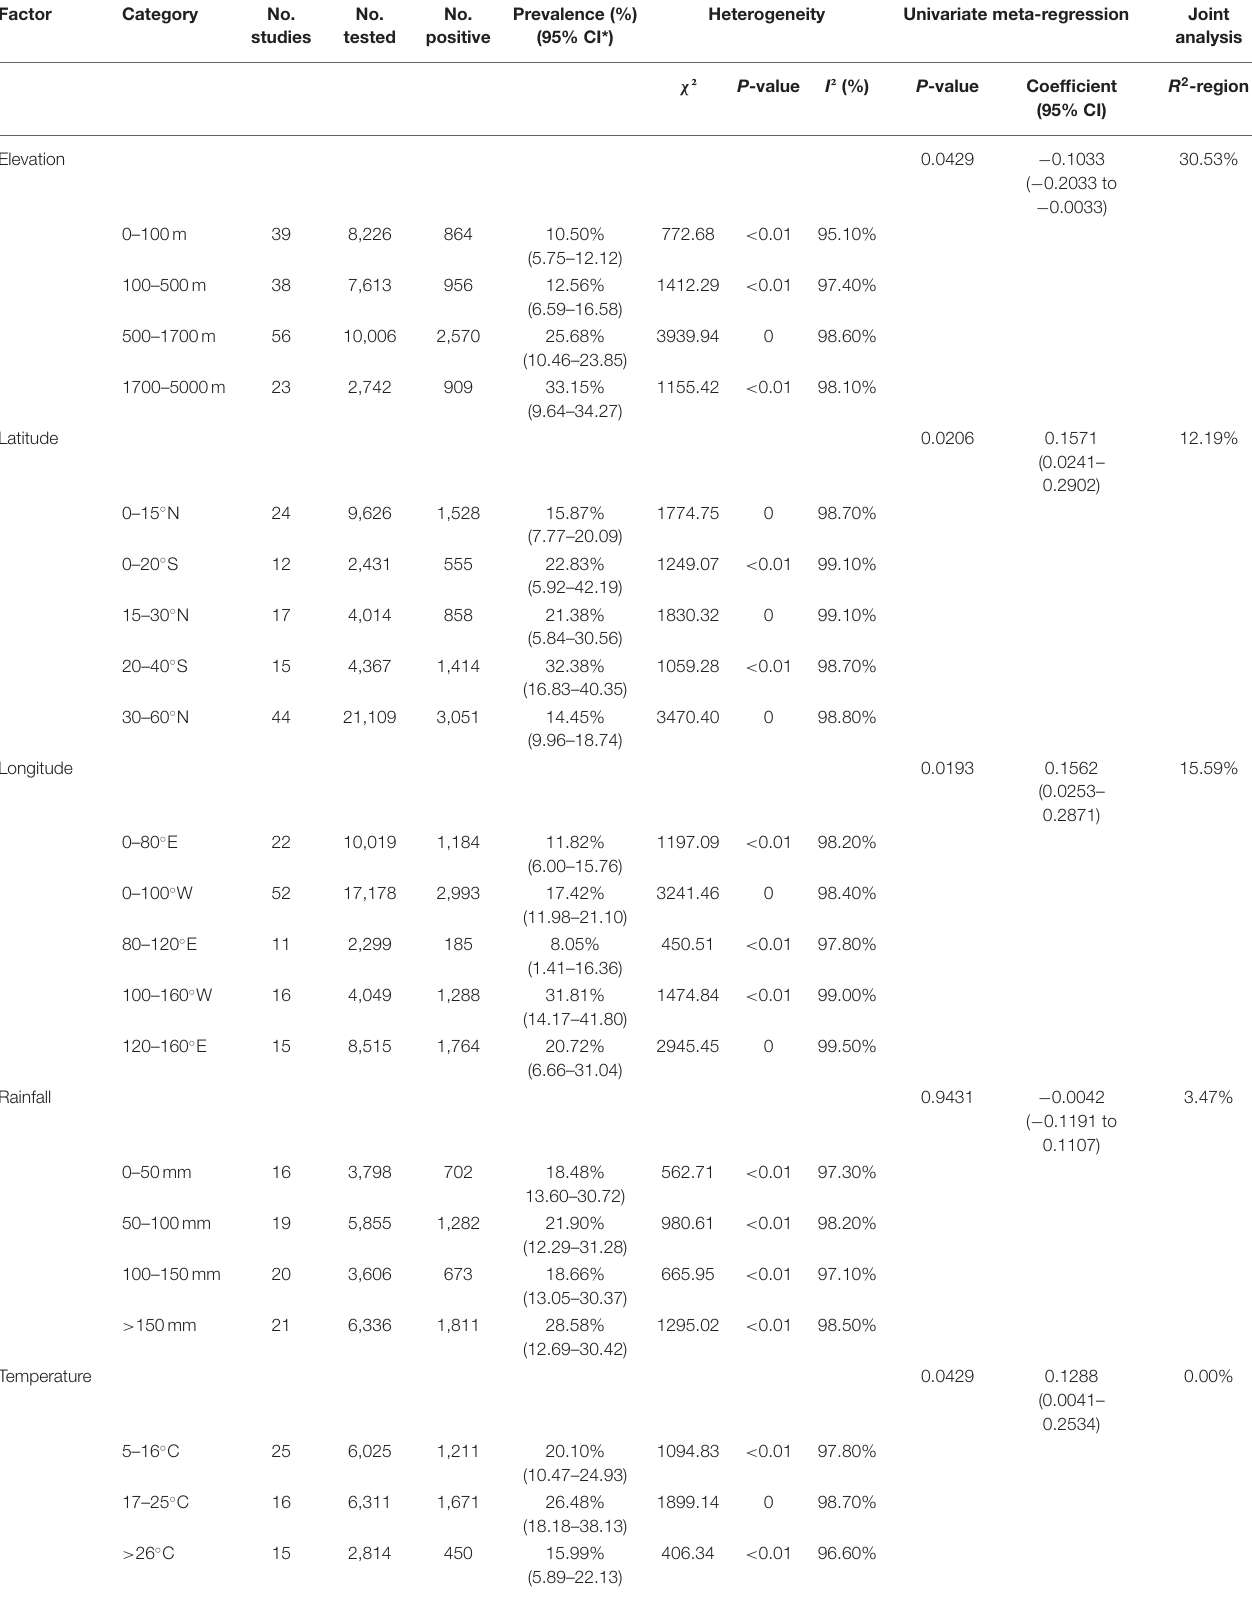
TABLE 2 | Estimated pooled prevalence of Batrachochytrium dendrobatidis by geographical factor.